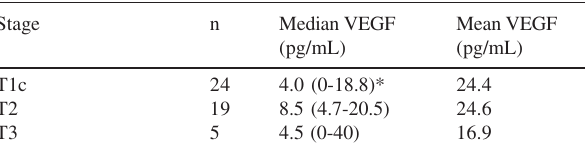
Table 4 - Plasma vascular endothelial growth factor (VEGF) levels according to clinical stage